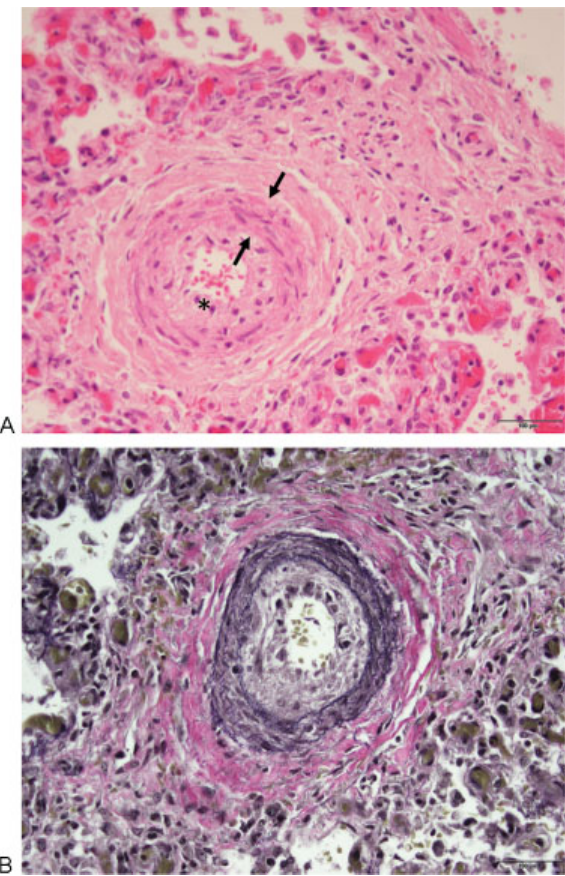
Fig. 3 Hematoxylin and eosin stain (A) of a typical arteriole showing increased cellularity in the intima ( (cid:3) ) and thickening of the tunica media (arrows). A corresponding elastic-van gieson stain (B) shows intimal hyperplasia and medial hypertrophy of the tunica media in a small artery (magni fi cation (cid:4)